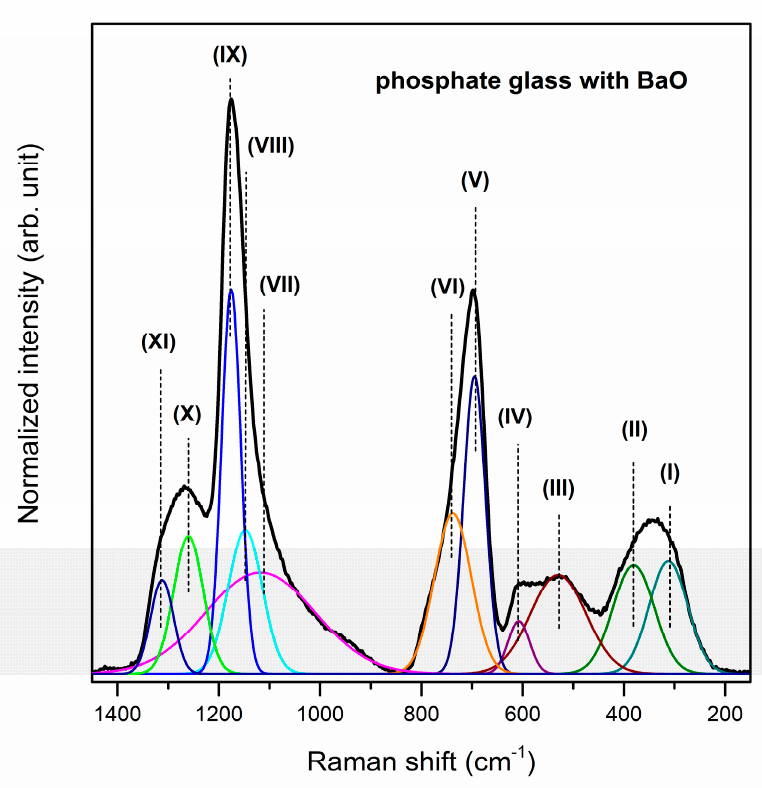
Figure 6. Deconvoluted Raman spectra of phosphate glass with BaO as oxide glass modifier.